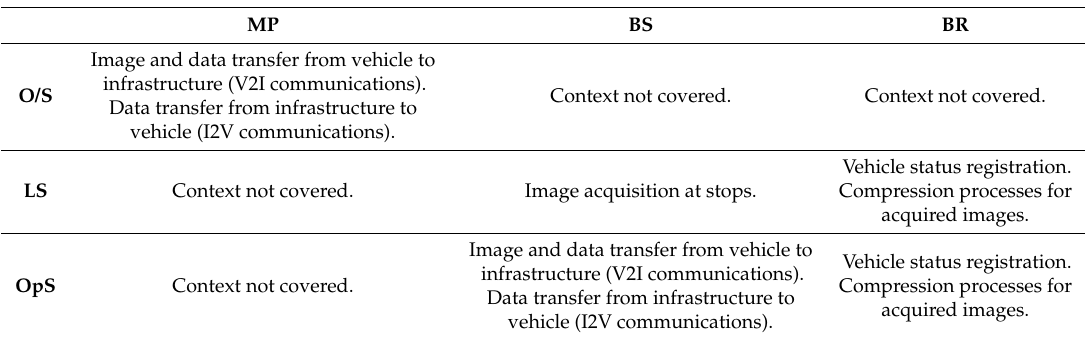
Table 2. Bus stop surveillance system context